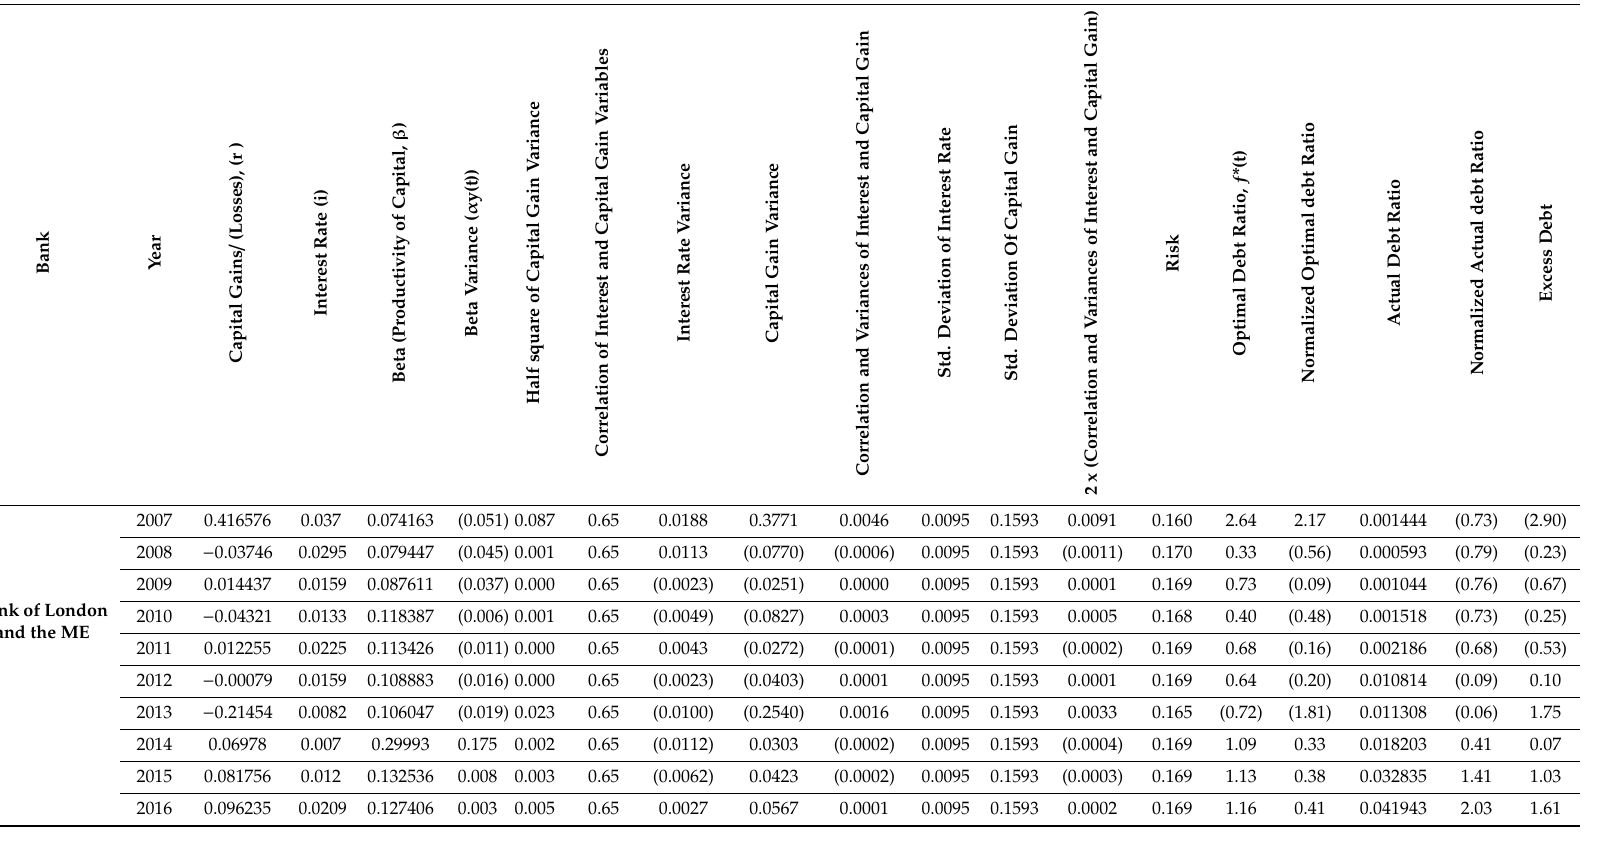
Table A20. Calculations of Optimal and Excess Debt: Bank of London and the